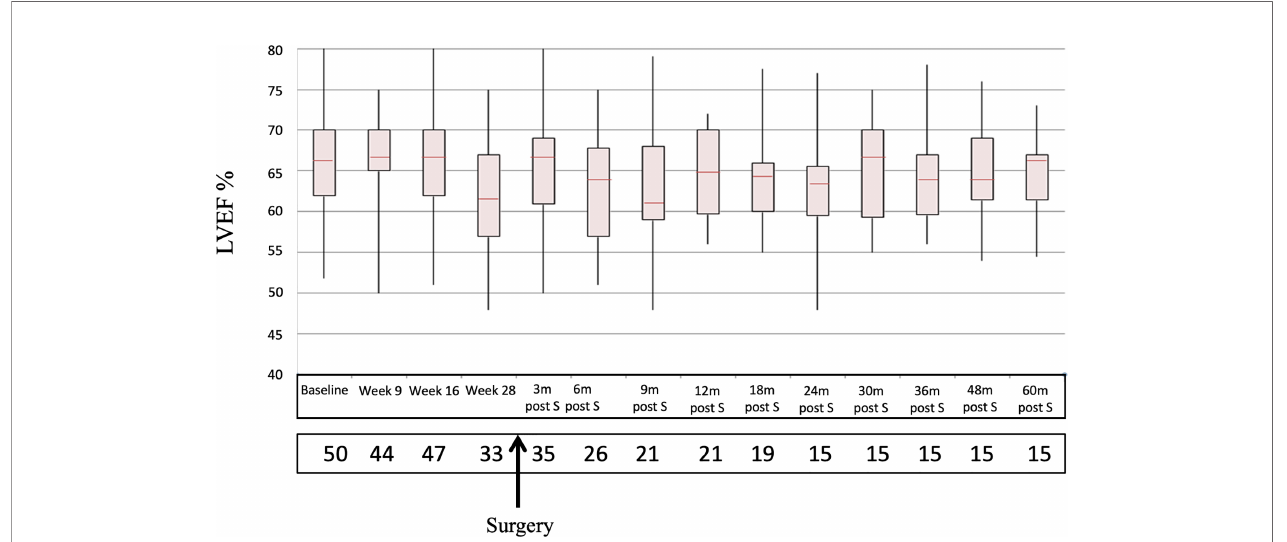
FIGURE 3 | Sequential LVEF determinations since baseline to 60 m post-S. LVEF, Left Ventricular Ejection Fraction; M, months; post-S, post surgery.